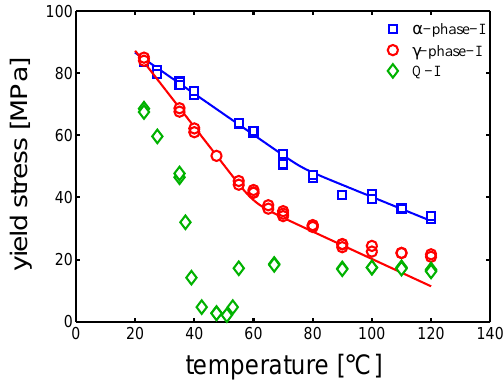
Figure 9. Yield stress versus testing temperature of samples tested with a strain rate of 10 − 2 s − 1 and several temperatures. The lines are the results of Equation (1) in which the strain rate is a fixed value (10 − 2 s − 1 ) and the temperature is ranging from 23 to 120